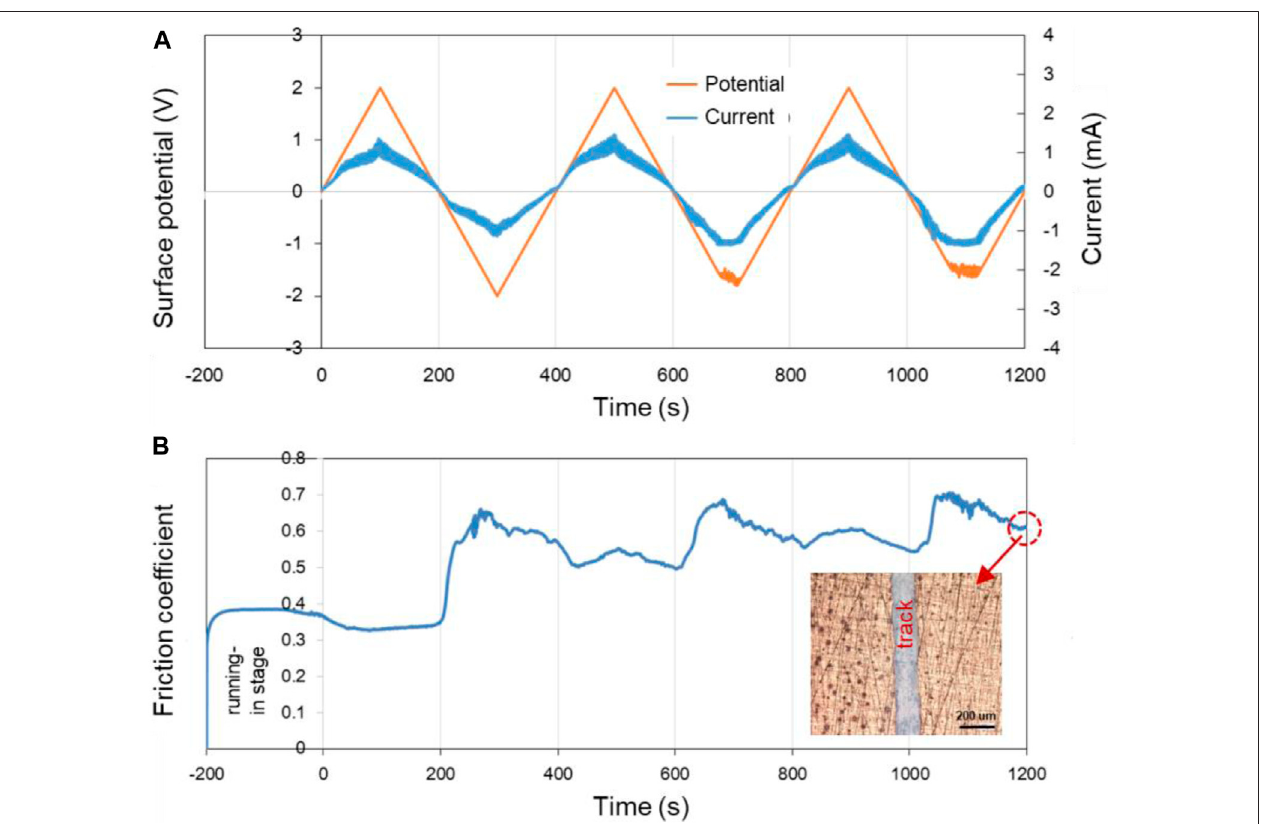
FIGURE 7 | Potential-controlled friction results of the Cu plate vs. ZrO 2 ball with pure H 2 O as lubricant and the Cu surface potential controlled among ± 2.0 V. (A) ThechangeofsurfacepotentialandcurrentofCuplateovertimeand (B) thevariationcurveoffrictioncoef fi cientwithtimeundertheappliedsurfacepotentialsin (A) .The insert in (B) shows the microscopic morphology near the track after the friction